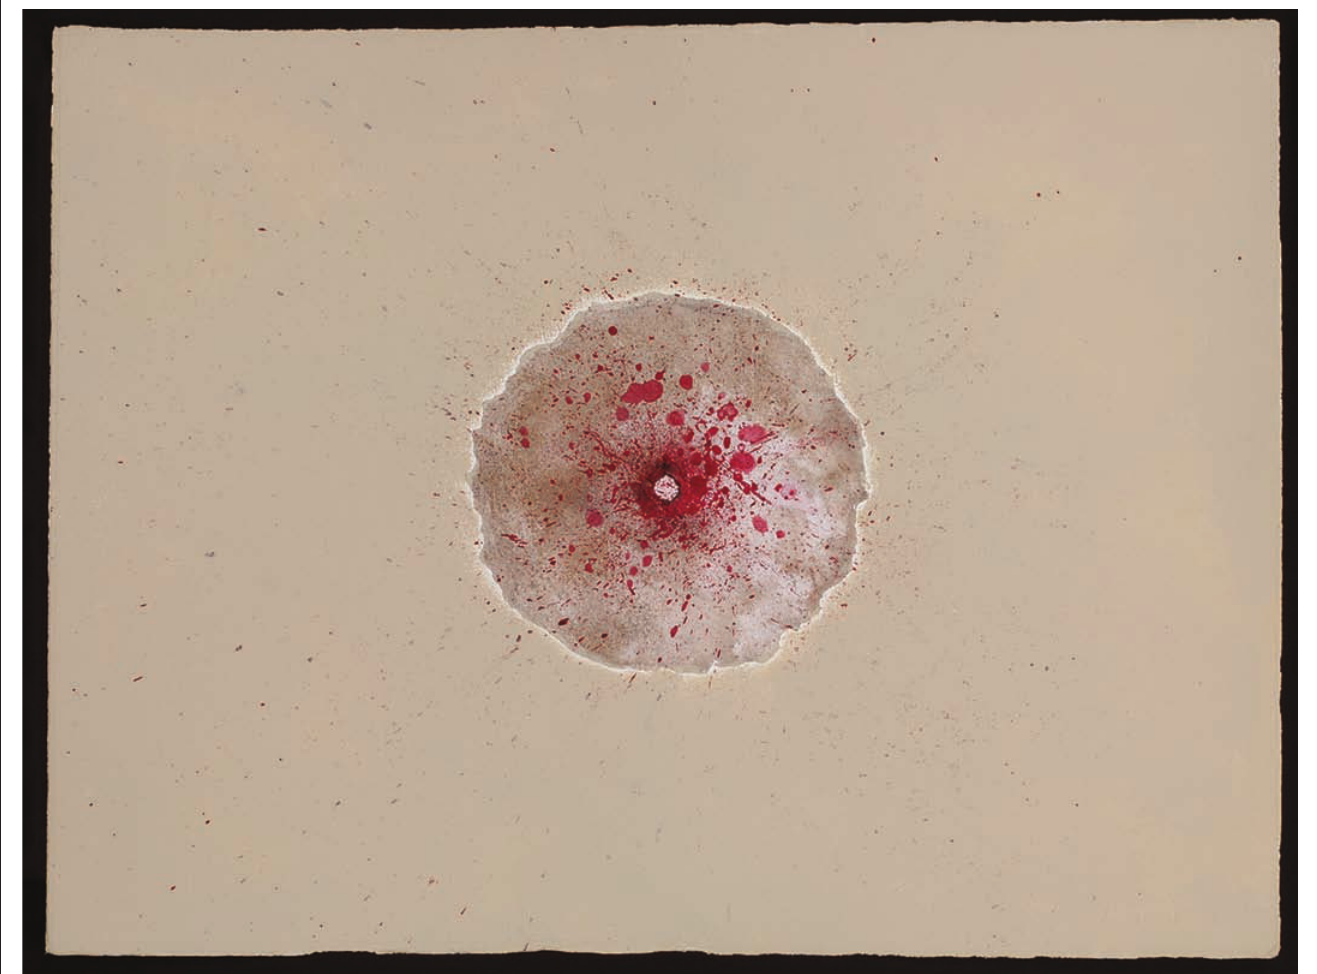
Figure 10 A Brian Graham painting inspired by an impact punctured horse scapula, from his recent work “The Book of